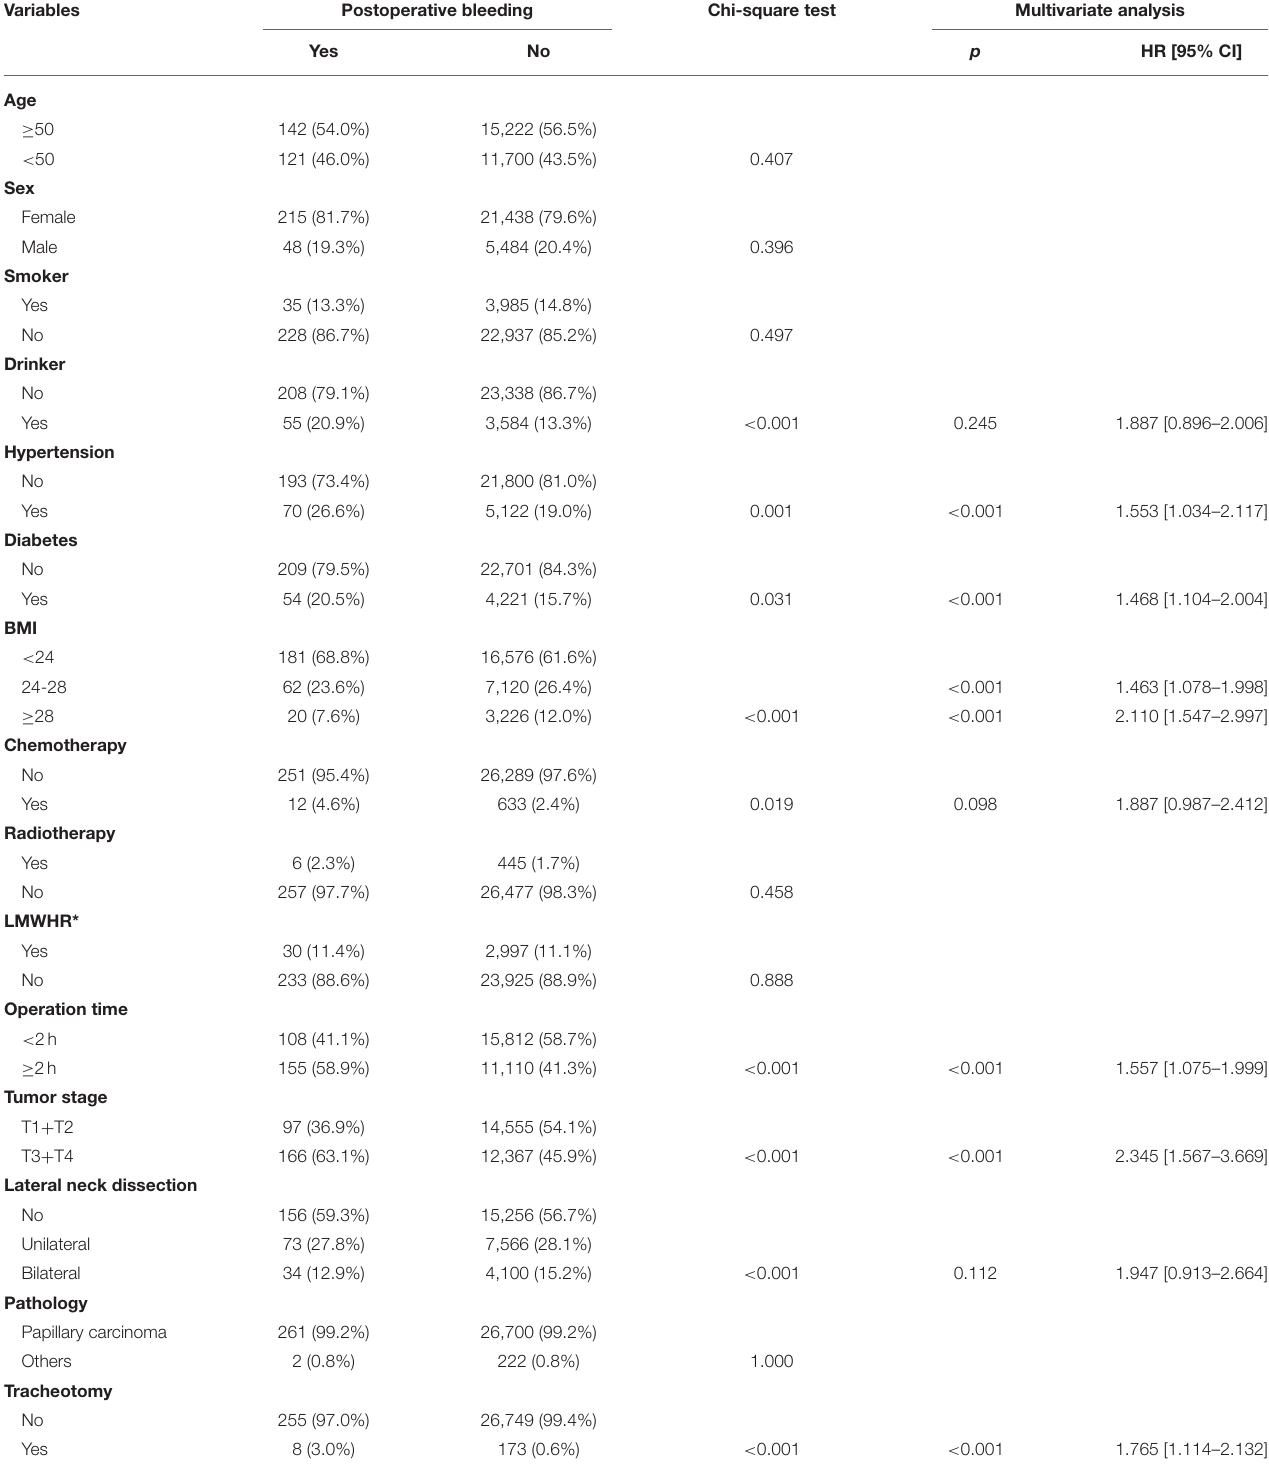
TABLE 3 | Association between clinical pathologic variables and postoperative bleeding in patients with malignant disease. Variables Postoperative bleeding Chi-square test Multivariate